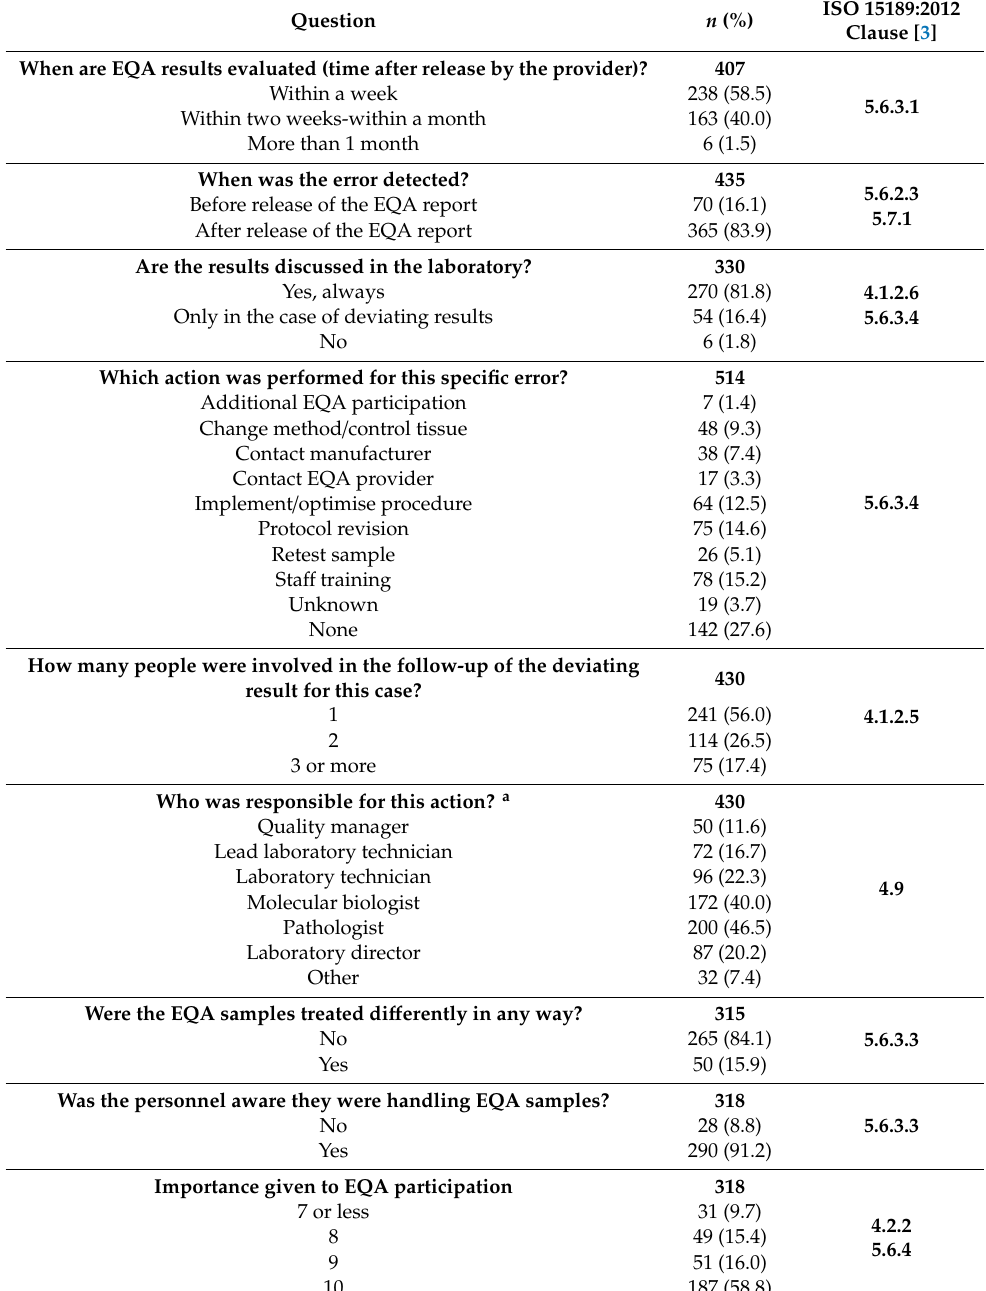
Table 2. Laboratories’ practices in processing feedback on cases with deviating EQA results, related to ISO 15189